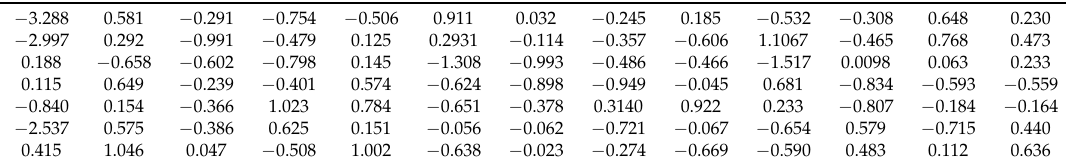
Table 6. The input weight values of the GA-BPNN.